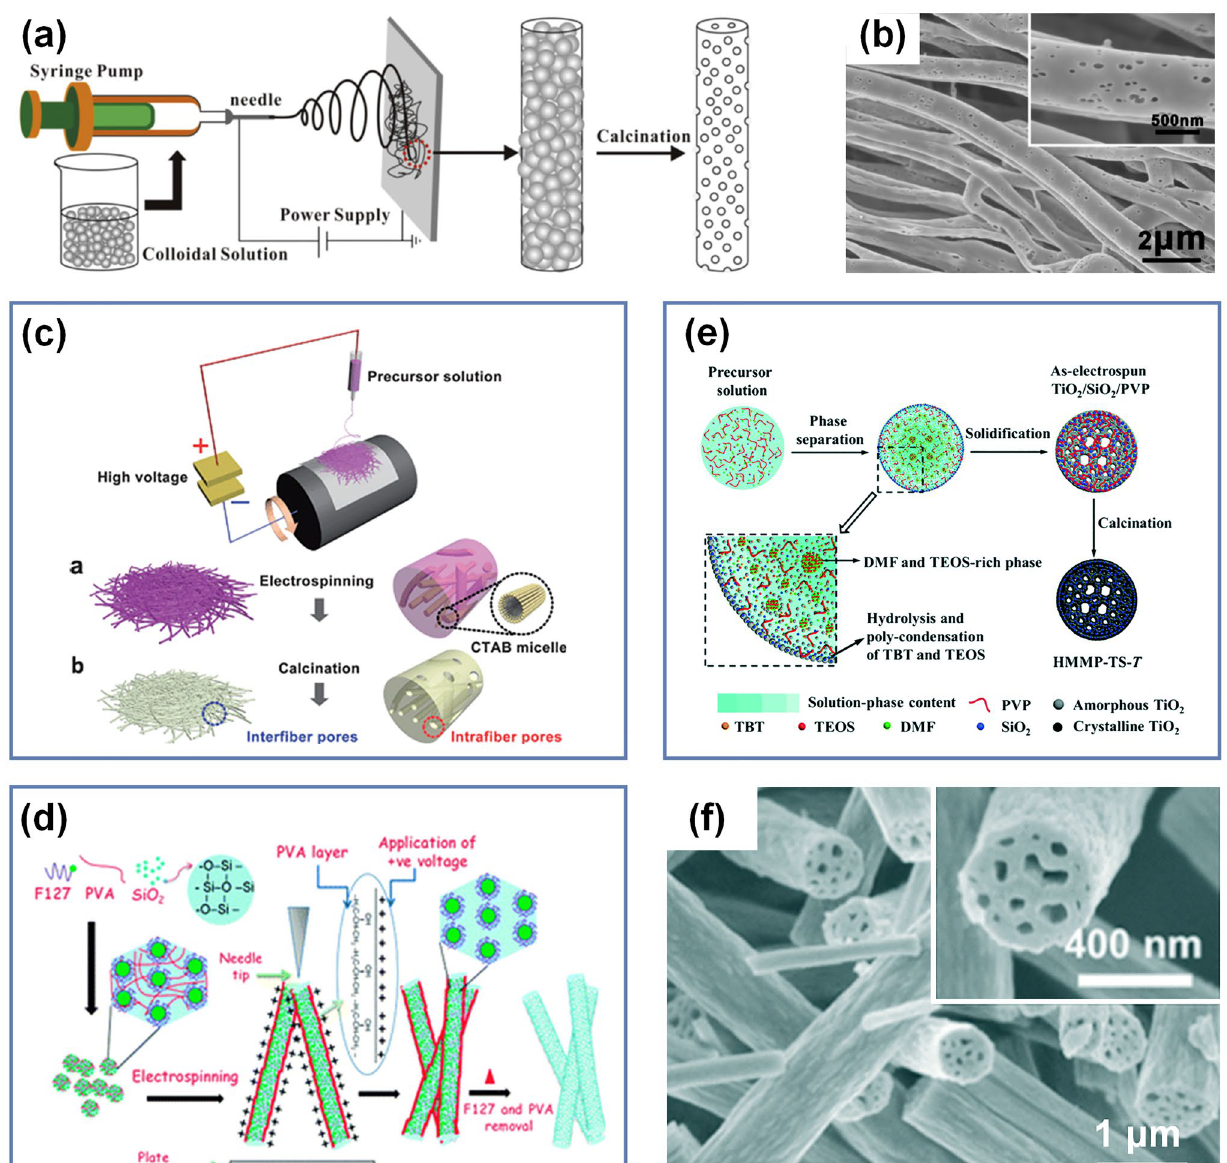
Fig. 5 a Schematic demonstration of fabrication procedure of the porous SNFs [102]. b SEM image of porous SNFs. The inset is the corre‑ sponding magnified SEM image [102]. Copyright 2014, Elsevier. c Schematic diagram of the preparation process of porous SiO 2 ‑TiO 2 com‑ posite nanofibers [109]. Copyright 2013, The Royal Society of Chemistry. d Proposed mechanism of order mesoporous SNFs [110]. Copyright 2013, The Royal Society of Chemistry. e Schematic illustration of the formation process of hierarchically porous TiO 2 ‑SiO 2 nanofibers [112]. f SEM images of TiO 2 ‑SiO 2 nanofibers. The inset is the corresponding magnified SEM image of single nanofiber cross section [112]. Copyright 2017, The Royal Society of